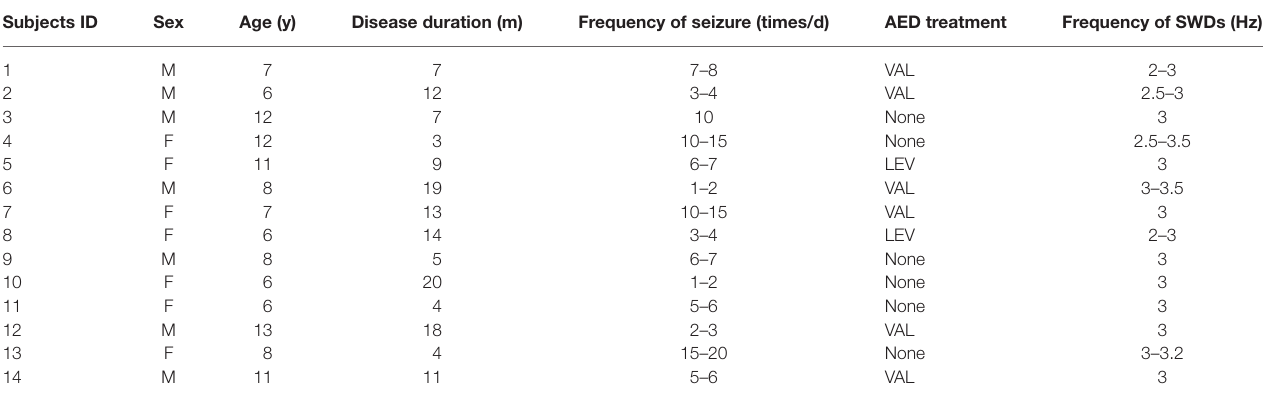
TABLE 1 | Clinical information for childhood absence epilepsy (CAE) patients. Subjects